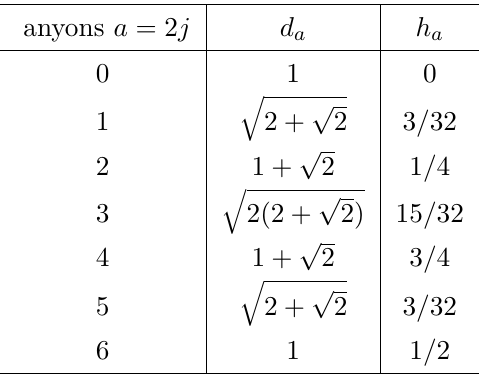
Table 1 . su (2) 6 topological sectors, quantum dimensions, and topological spins. The label 2 j gives the SU(2) spins of the corresponding sector.